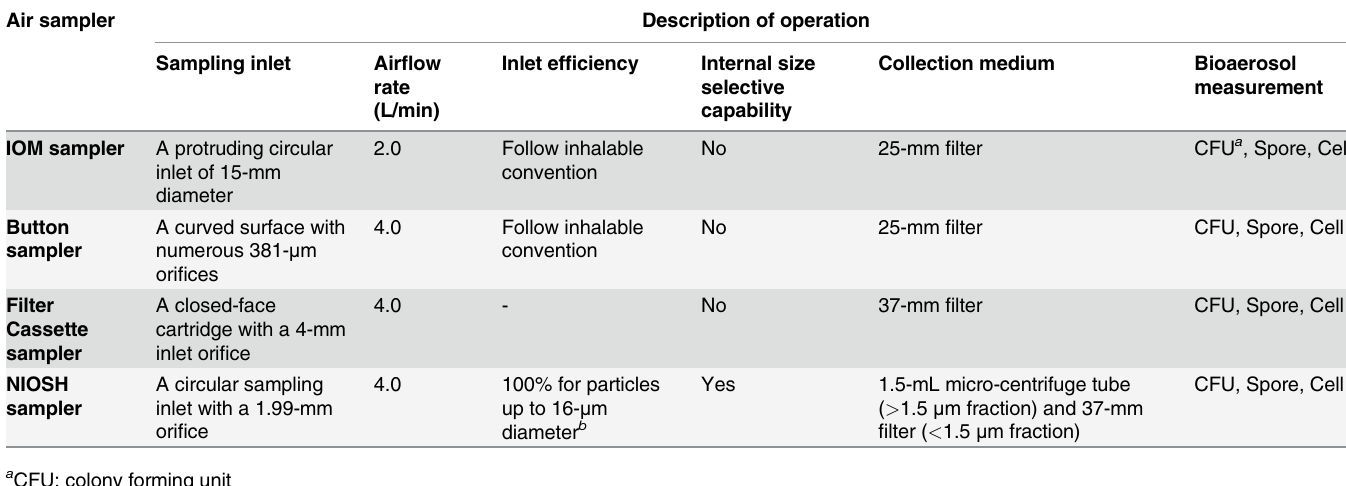
Table 1. Characteristics of the tested personal bioaerosol